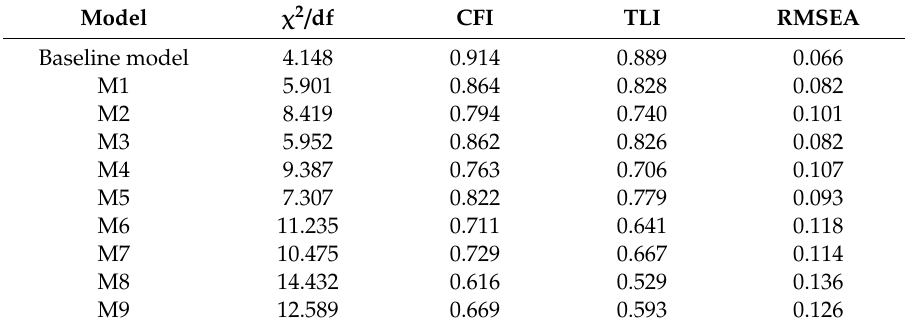
Table 3. Comparison of measurement models.